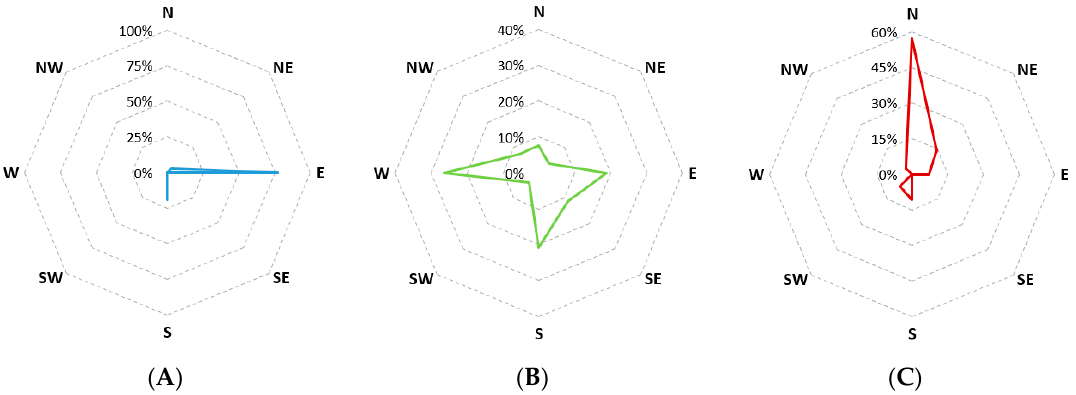
Figure 5. Position of the occupants’ working planes concerning the orientation of the building façade where the office spaces were located for each examined building (Building A : left, Building B : middle, Building C : right).